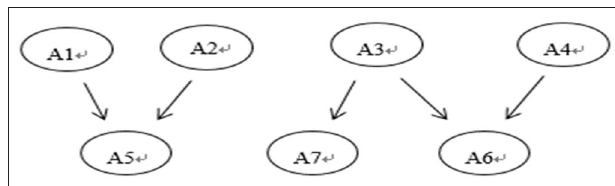
FIGURE 3 | The attribute hierarchy relationship of the